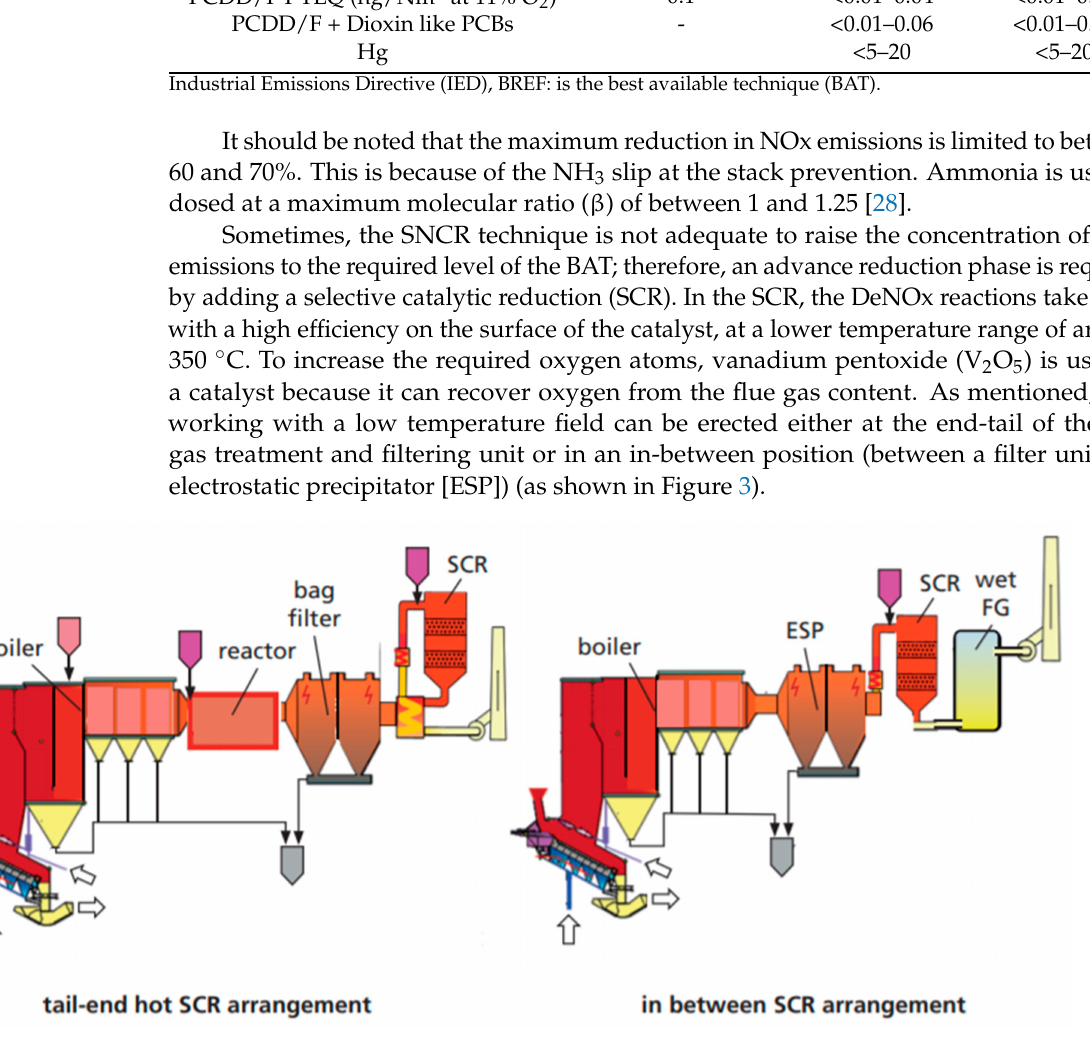
Figure 3. Arrangement of an SCR system in the flue gas treatment of the plant